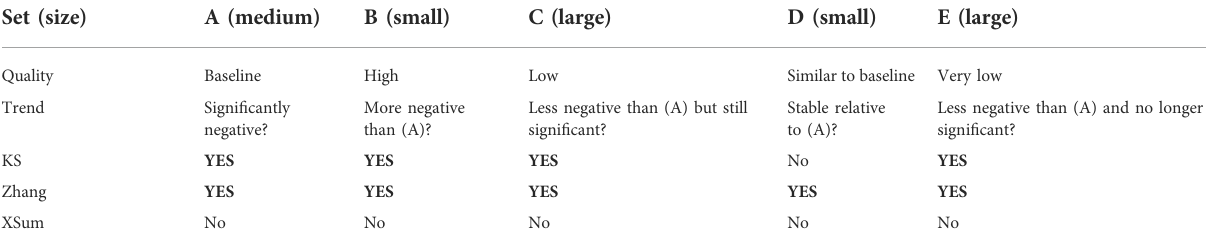
TABLE 6 Summary of changes in KS, Zhang and XSum scores with respect to disease signatures quality.